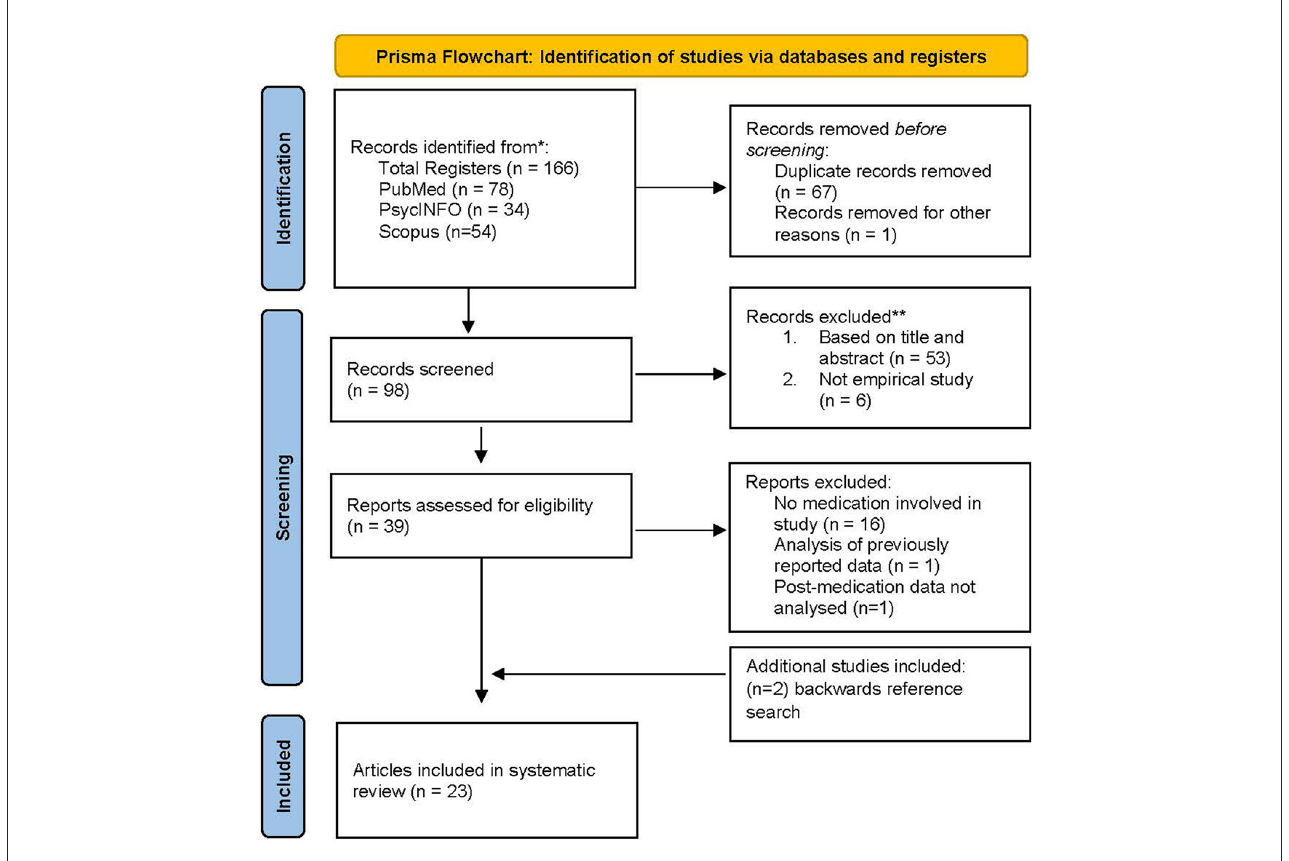
FIGURE1 PRISMA flow diagram showing search and study selection.